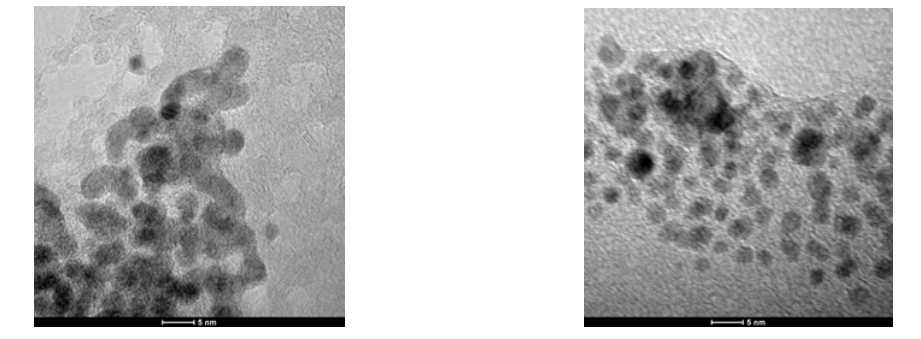
Figure 11. TEM micrograph of G3-Pd isolated after Suzuki-Miyaura